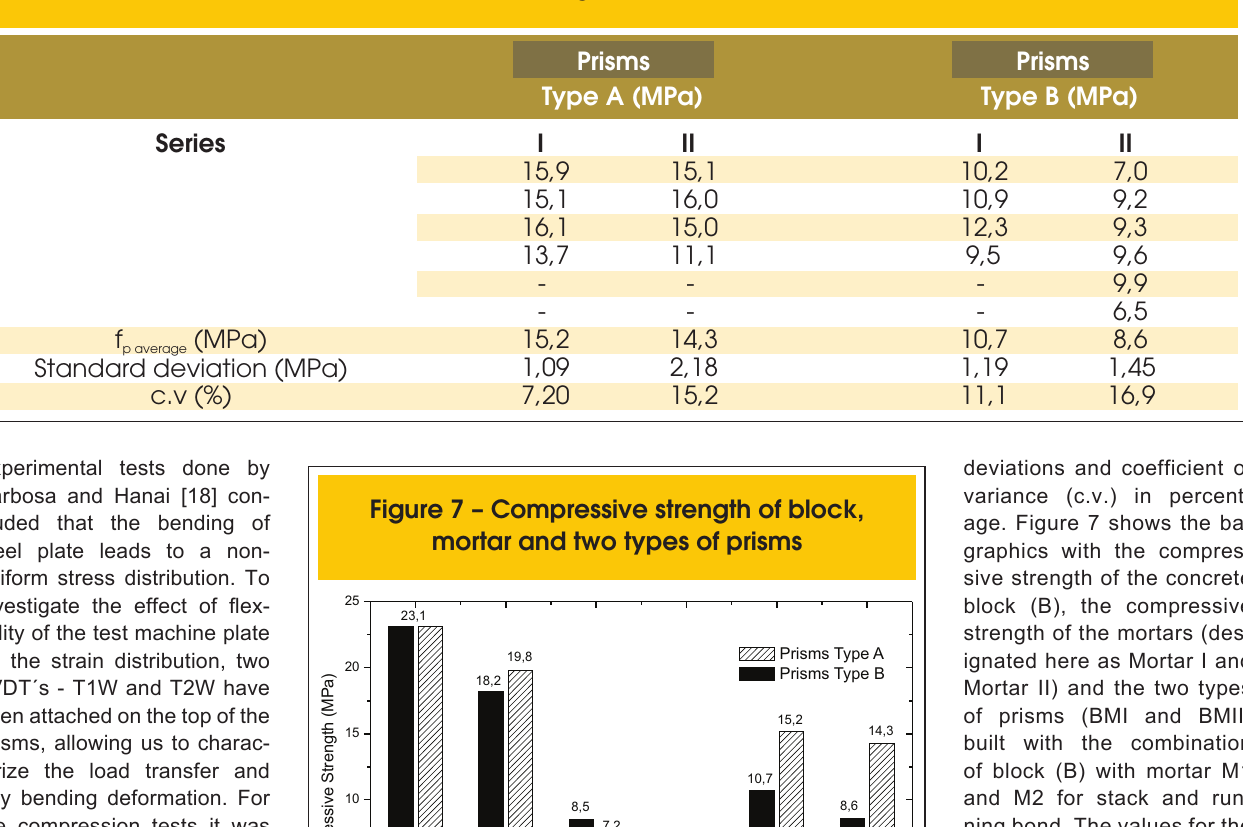
Table 3 – Compressive strength of prisms with statistical results